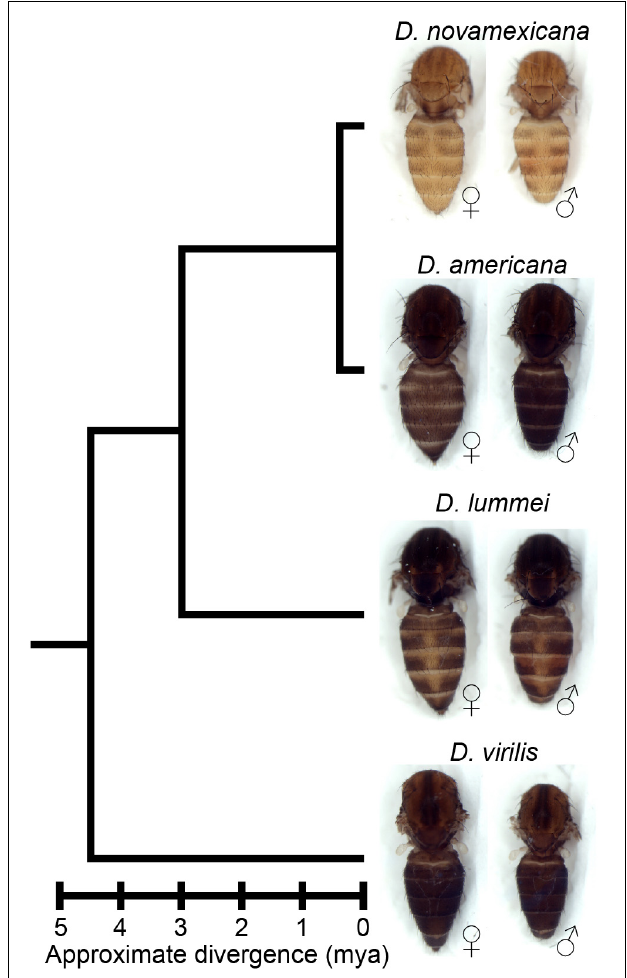
FIGURE 1 | Drosophila novamexicana shows divergent body color within the virilis group. Phylogenetic relationships with estimated divergence times (Caletka and McAllister, 2004; Cooley et al., 2012) are shown for D. novamexicana , D. americana , D. lummei , and D. virilis . For each species, a dorsal view of the thorax and abdomen is shown for females (left) and males (right), with heads, wings, and legs